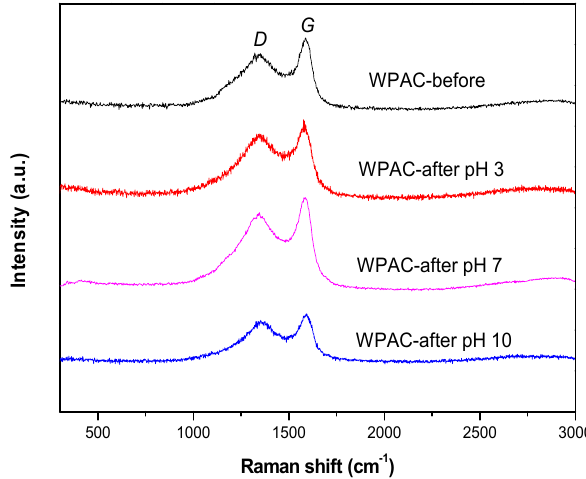
Figure 4. Raman spectra of WPAC before and after Cr(VI) adsorption at pH 3, 7, and 10.